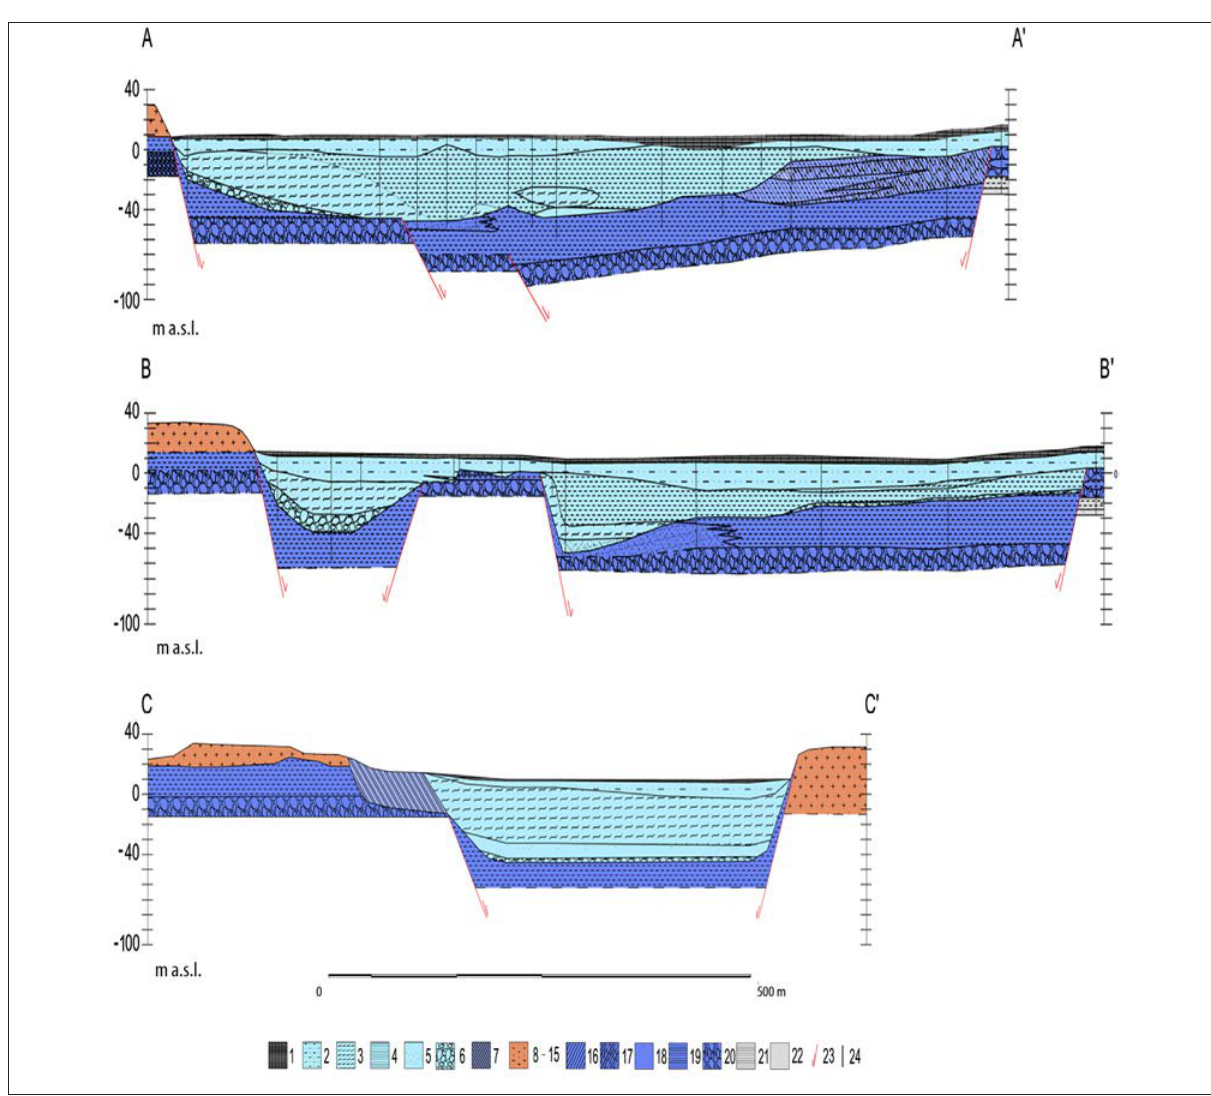
Figure 12. Geological cross sections along AA’, BB’, CC’ in Figure 11. See Figure 4 for the key to the